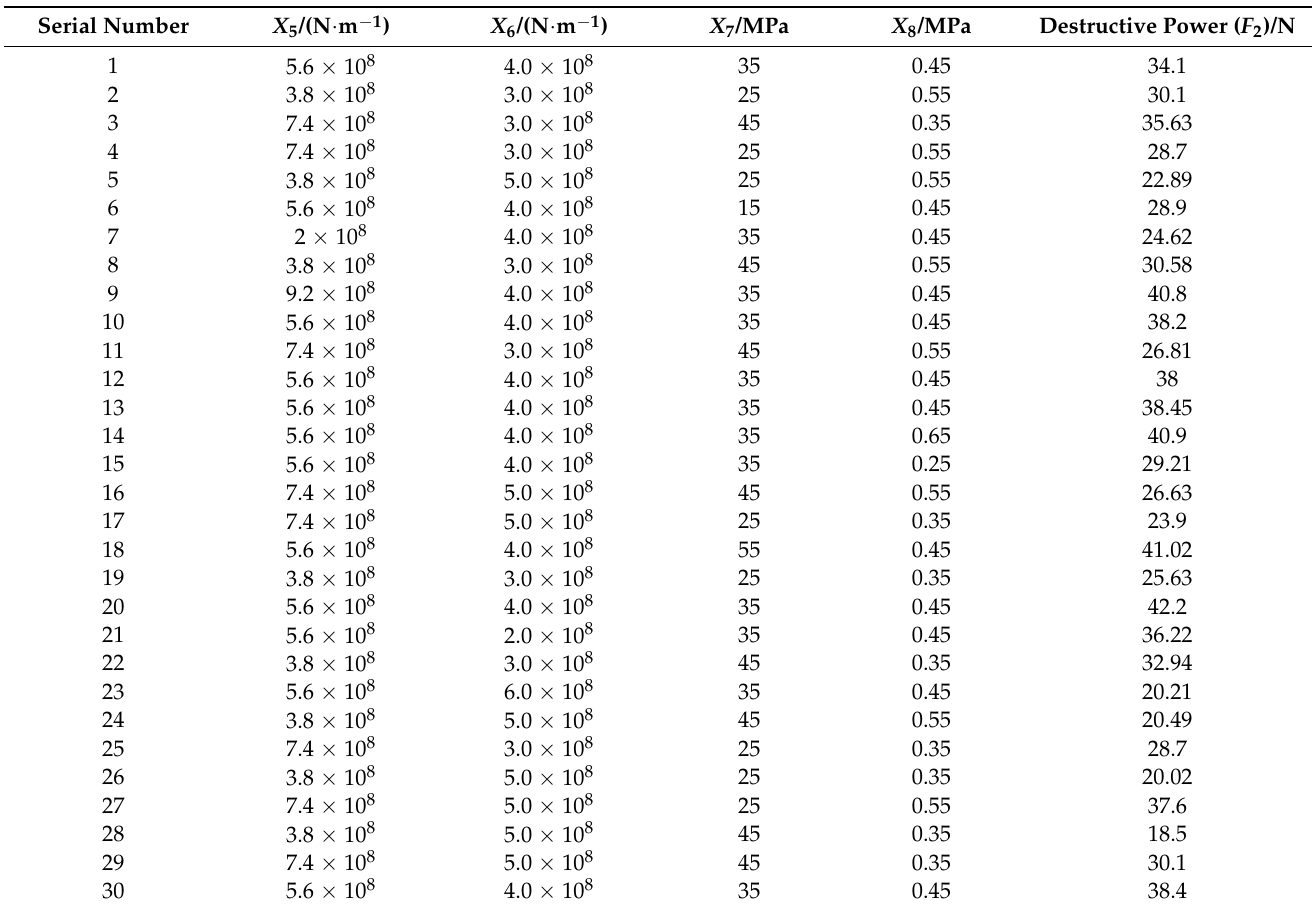
Table 7. Experimental design and results of internal flesh bonding